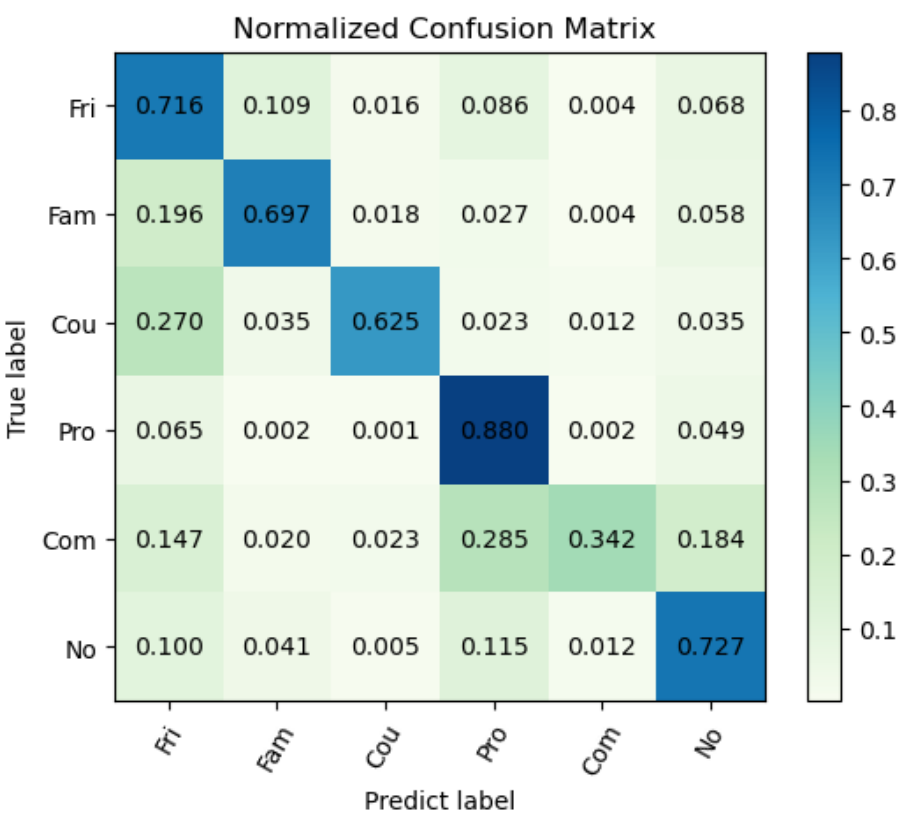
Figure 6. Confusion matrix of PISC-Fine task. The values on the leading diagonal denote the per-class